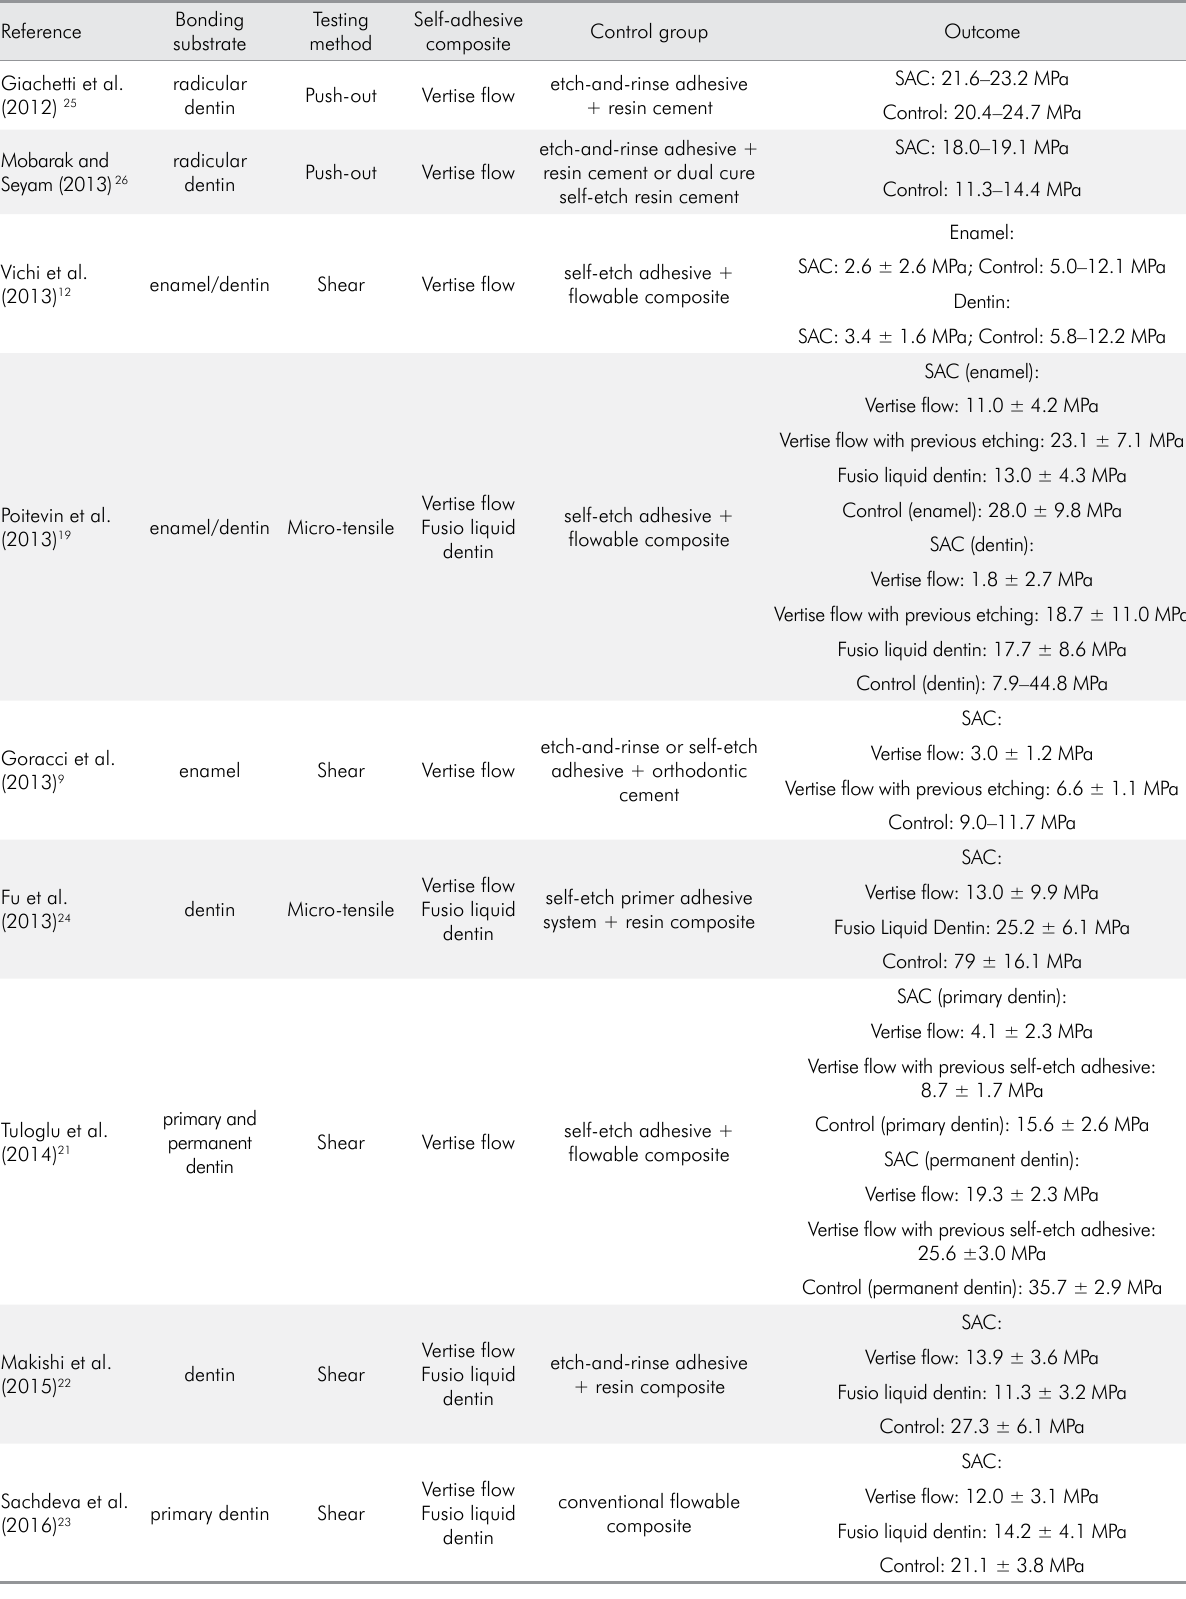
Table 2. Bond strength